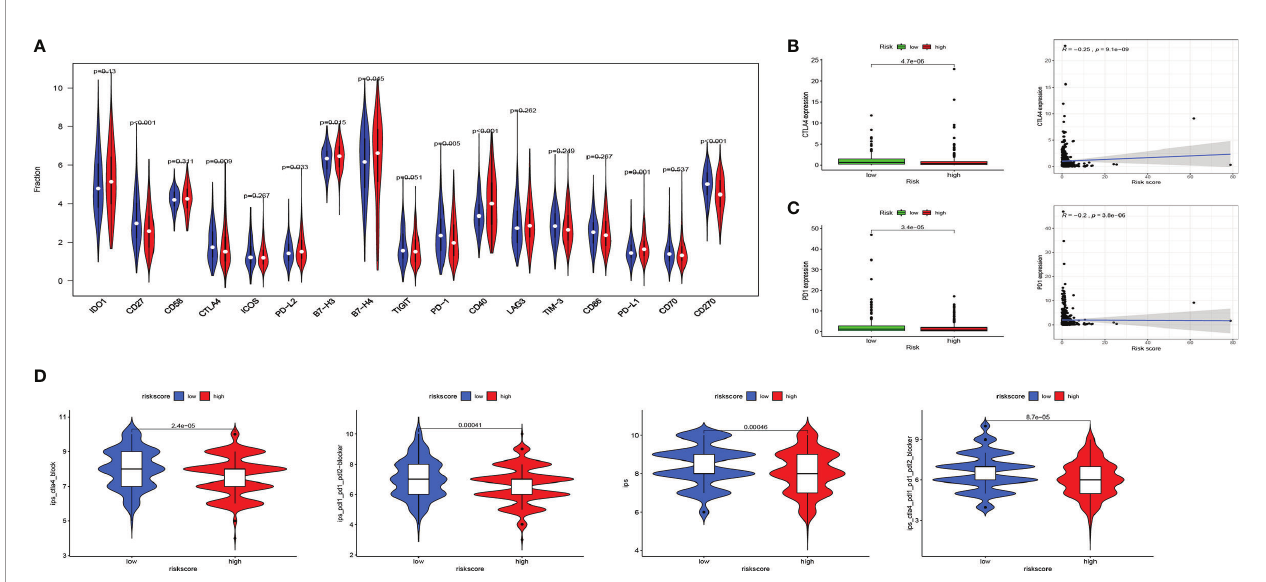
FIGURE 6 | Associations of immune cell in fi ltration, immune checkpoints expression, and IPS and the EMT-related risk signature. (A) The distribution of immunomodulators in high-risk and low-risk groups. (B, C) The expression of 2 immune checkpoint molecules (CTLA4 and PD1) in high-risk and low-risk groups and Pearson ’ s correlation coef fi cient calculated between risk score and 2 immune checkpoint molecules. (D) The association between IPS and the risk score in EC patients. IPS, immune prognostic signature; EMT, epithelial – mesenchymal transition; EC, endometrial cancer.